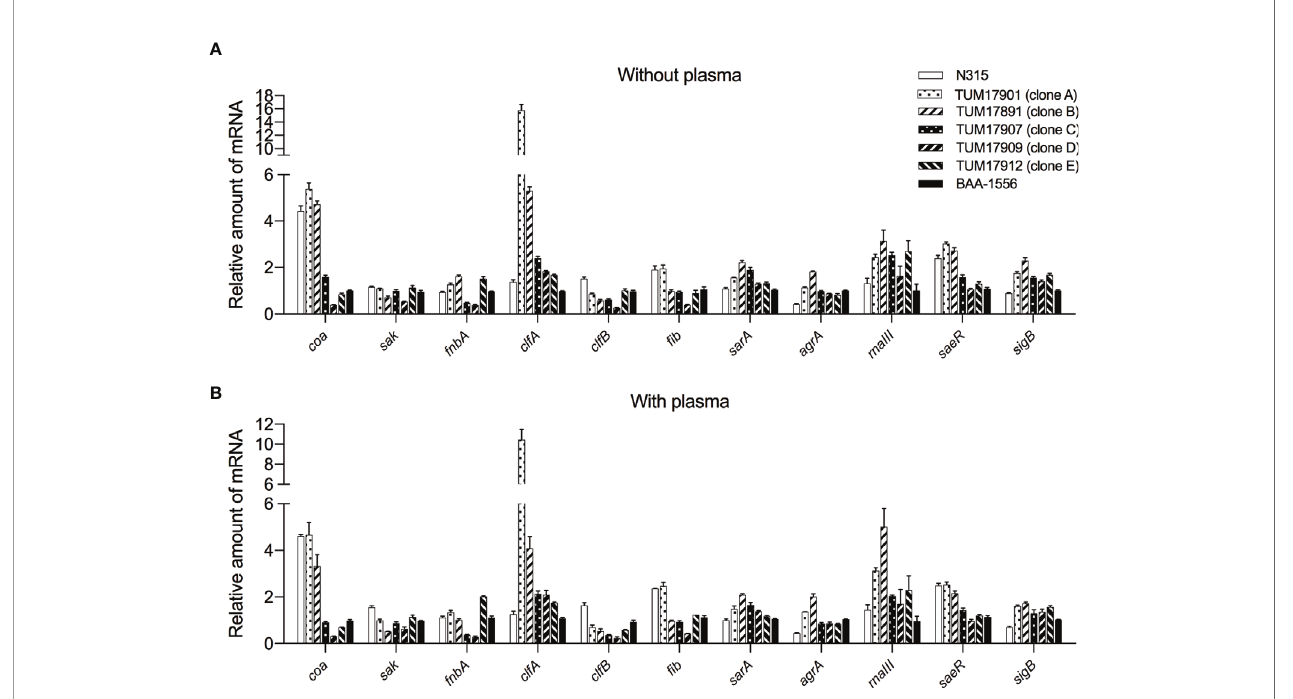
FIGURE 5 | Measurement of bio fi lm-related gene transcription by reverse-transcription quantitative PCR (RT-qPCR). (A) Transcript levels of each strain after 1 h of incubation without plasma. (B) Transcript levels of each strain after 1 h of incubation with plasma. Two wells were used for each strain per experiment, and the experiment was conducted three times. Data from the total of three experiments were compared between strains. The data were analyzed using the DD Ct method. The 16S rRNA gene was used as an internal